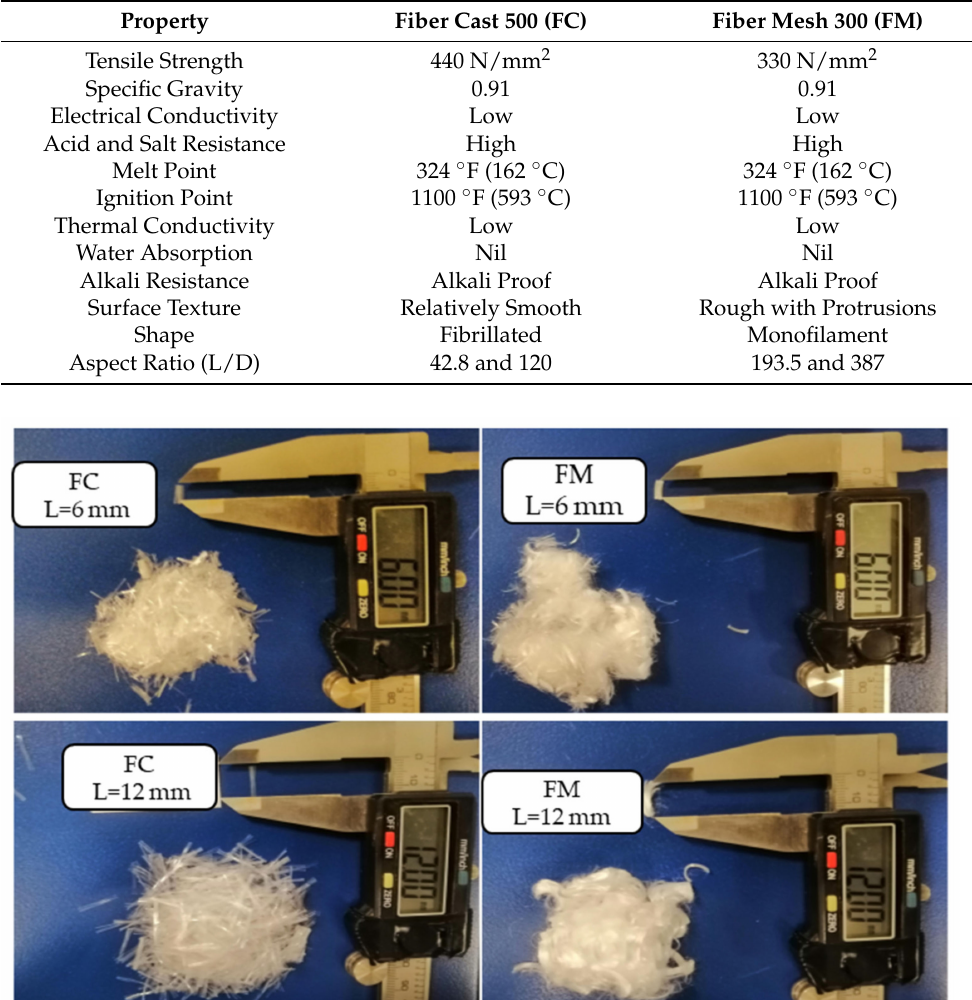
Figure 1. Fibers used in the